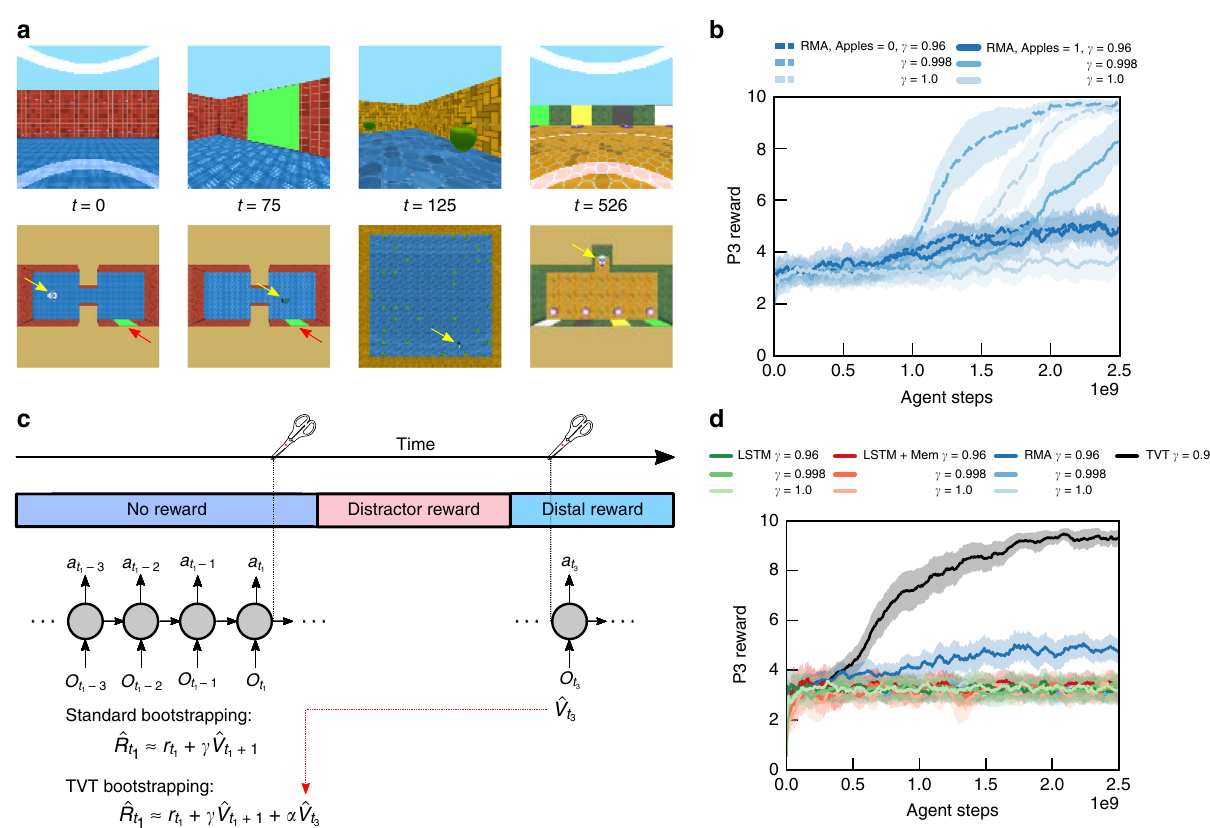
Fig. 2 Temporal Value Transport and type 1 information acquisition tasks. a First person (upper row) and top – down view (lower row) in Active Visual Match task while the agent is engaged in the task. In contrast to Passive Visual Match, the agent must explore to fi nd the colored square, randomly located in a two-room environment. The agent and colored square are indicated by the yellow and red arrow, respectively. b Without rewards in P2, RMA models with large discount factors (near 1) were able to solve the task; the RMA with γ ¼ 0 : 998 exhibited retarded but de fi nite learning with modest P2 reward (1 point per apple). c Cartoon of the Temporal Value Transport mechanism: the distractor interval is spliced out, and the value prediction ^ V t point t 3 in P3 is directly added to the reward at time t 1 in P1. d The TVT agent alone was able to solve Active Visual Match with large rewards during the P2 distractor (Supplementary Movie 1) and faster than agents exposed to no distractor reward. The RMA with discount factor γ ¼ 0 : 96 was able to solve a greater than chance fraction because it could randomly encounter the colored square in P1 and retrieve its memory in P3. In b , d , error bars